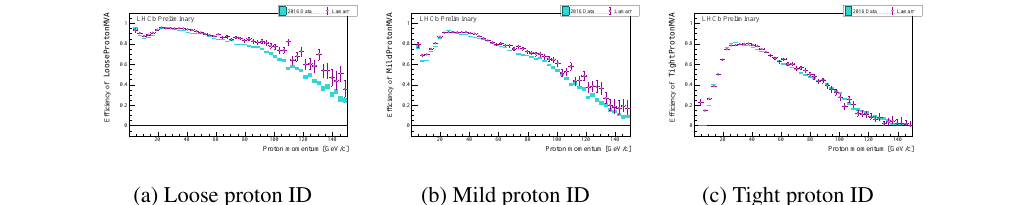
Figure 7: Comparing proton identification e ffi ciency. E ffi ciency of three di ff erent require- ments on the output of a Multi-Layer Perceptron trained to identify protons as evaluated on → Λ + → pK − π + . The e ffi ciency is com- µ ¯ ν µ with Λ + protons tagged through the decay Λ 0 c c b pared, in bins of the proton momentum, for a dataset selected without introducing bias on the particle identification of the proton (cyan shaded area), and a Fast Simulation (Lamarr) sample where the rich and the calorimeter responses are modeled through a Generative Ad- versarial Network trained using protons from Λ 0 → p π − decays, only (purple markers).